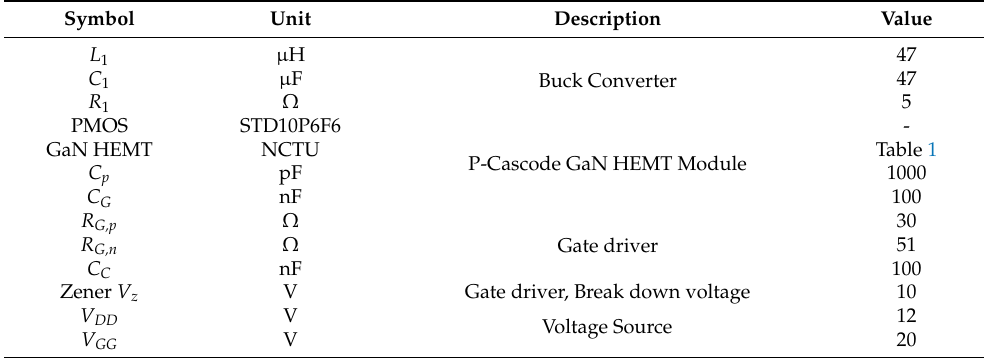
Table 2. Summary of the synchronous buck